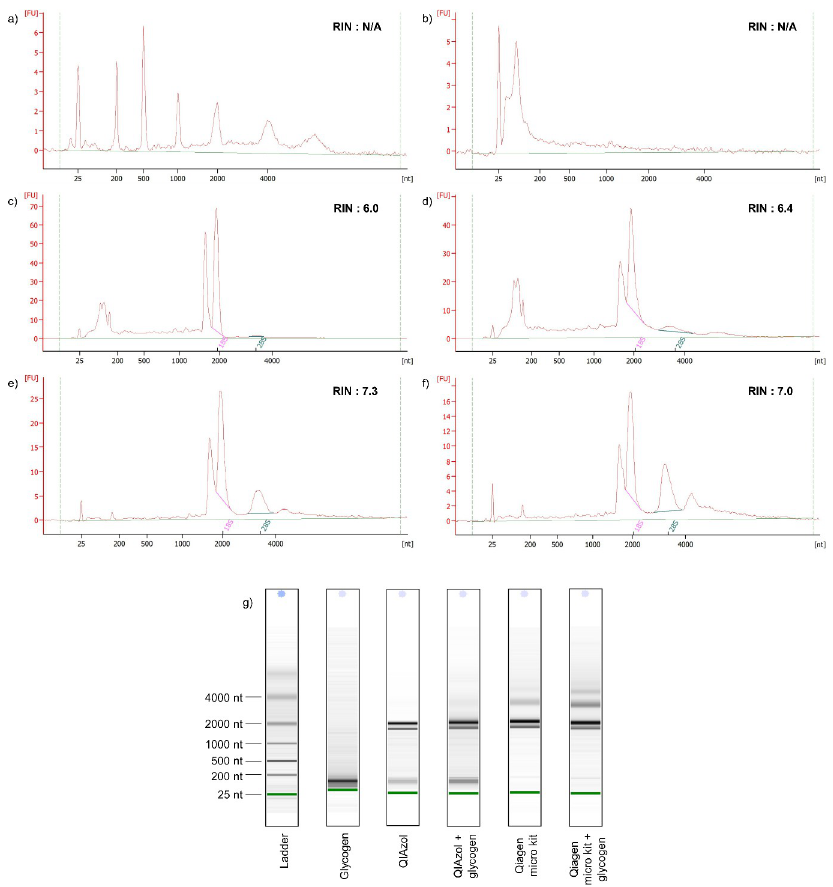
Fig 3. The bioanalyzer assessment of total RNA from ten (10) female M . micrura extracted using different RNA extraction methods with the agilent RNA 6000 pico kit on the agilent 2100 bioanalyzer. X-axis units in nt (Nucleotides); Y-axis units in FU (Fluorescence Units); N/A (Not Applicable) a) RNA ladder, b) glycogen, c) QIAzol method, d) QIAzol + glycogen method, e) Qiagen Micro Kit method, f) Qiagen Micro Kit + glycogen method, and g) Electrophoretic gel for each